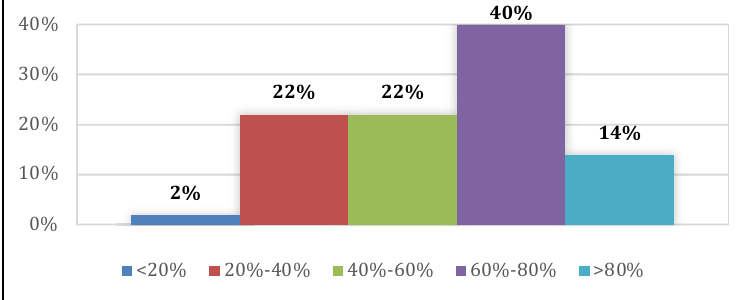
Fig. 6. Students perception of the overall course time devoted to the